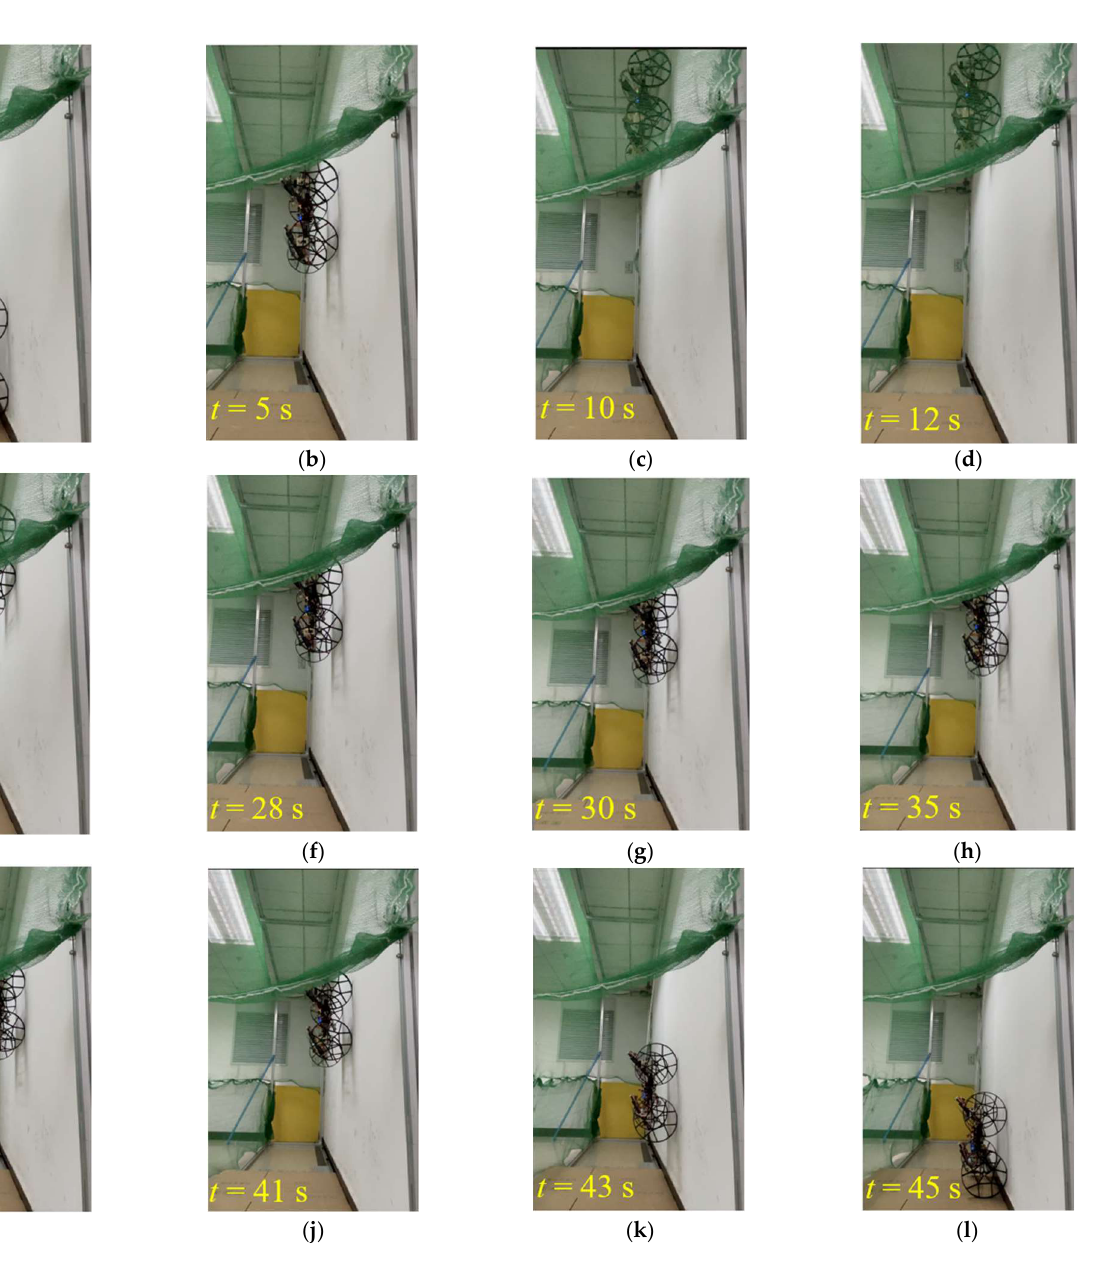
Figure 13. Wall variable-speed forward and backward experiment of DP-Climb: ( a – c ) wall forward movement; ( d – f ) wall deceleration backward movement; ( g – i ) wall static negative pressure adhesion; ( j – l ) wall acceleration backward movement.